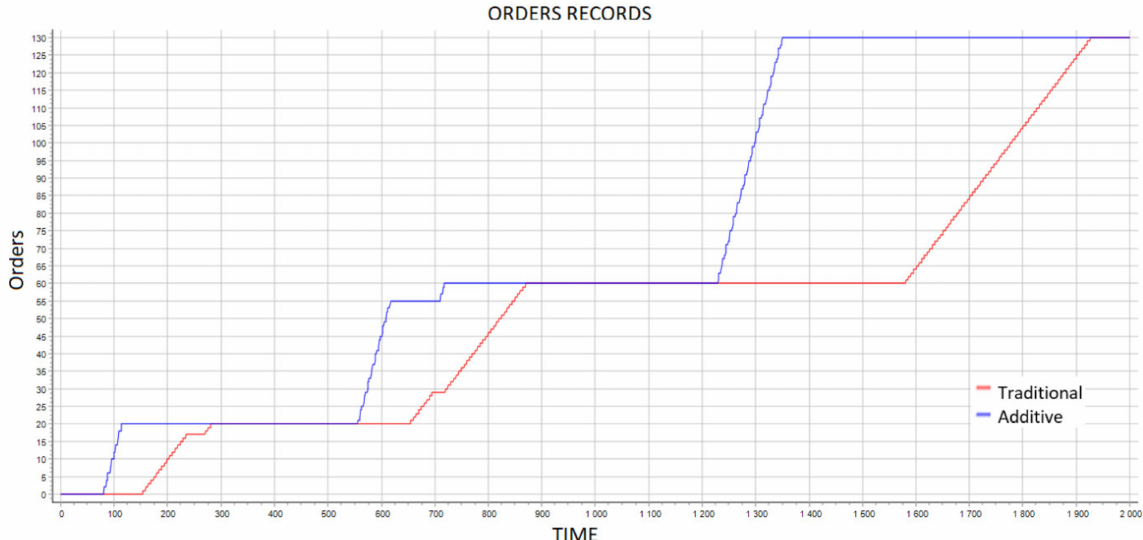
Figure 14. Order record of Demand 3. Source: Own elaboration. Evolution software.